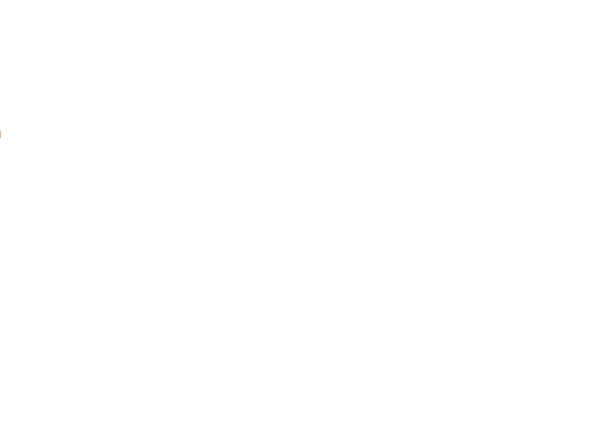
0.4 Figure 5. Normalized entry pressure variations with the contact angle (which was assumed to be the same at the surface of the membrane and inside the pore) for the case in which 𝑟 (cid:3031) = 40 μm , 𝑟 (cid:3043) = 2 μm , and 𝜎 = 0.035 N/m . The pressure value was normalized relative to the capillary pressure of the interface inside the pore, i.e., 2𝜎 cos𝜗 (cid:2870) 𝑟 (cid:3043) ⁄ . Figure 6. Succession of configurations of oil droplets at the surface of a membrane with different contact angles. When the contact angle is smaller, the droplet tends to spread over the surface more. 3.2. Critical Velocity of Dislodgment The decrease in the contact angle not only affects the magnitude of the entry pressure but also the magnitude of the critical velocity of dislodgment. When the droplet spreads over the surface more, it requires a larger velocity for its dislodgement. Figure 7 shows a 00.2